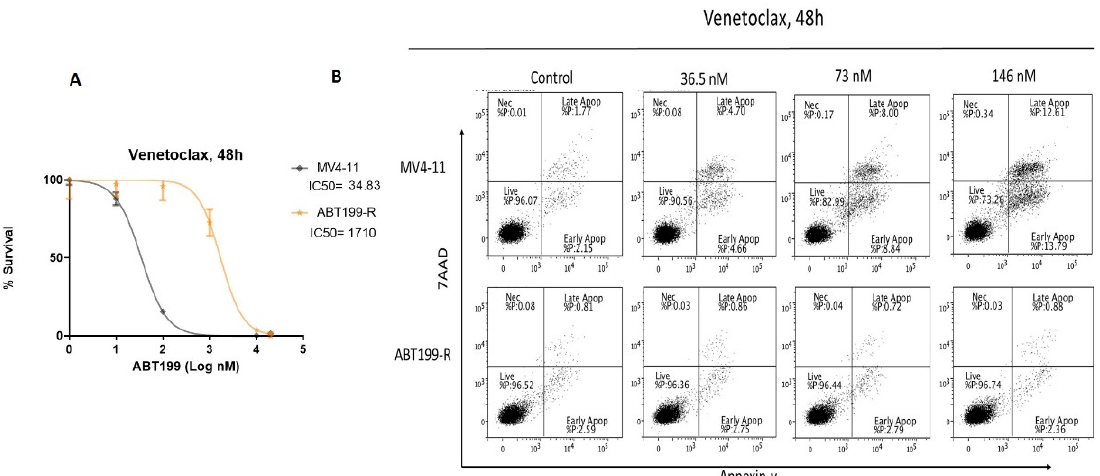
Figure 1. ABT199-R cells are highly resistant to venetoclax. ( A ) MV4-11 and ABT-199R were treated with increasing doses of venetoclax (0–20 µ M) for 48 h and assessed with a cell titer blue proliferation assay. The curves indicate the percentage survival of each cell line to increasing doses of venetoclax. ( B ) MV4-11 and ABT199-R cells were treated with indicated concentrations of venetoclax for 48 h and stained for an Annexin-V/7AAD assay. The percentage values determine the early and late apoptotic populations.